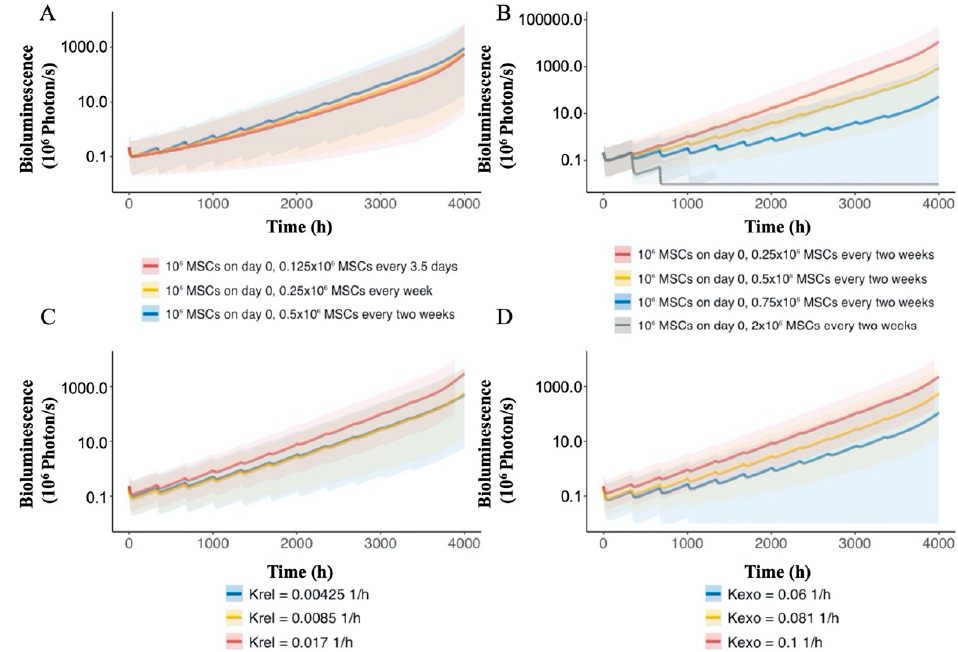
Figure 8. Simulated tumor bioluminescence–time profiles with different nano-MSCs dosing intervals ( A ), different nano-MSCs maintenance doses ( B ), different K rel ( C ) and different K exo ( D ). The medians of the tumor bioluminescence profiles are represented by solid lines. The areas between the 10th and 90th percentiles of the tumor bioluminescence profiles are represented by shaded areas. The colors represent the simulation conditions as shown in the respective figure legends. Note: 10 6 nano-MSCs is equivalent to 25 µg (1.25 mg/kg) PTX.